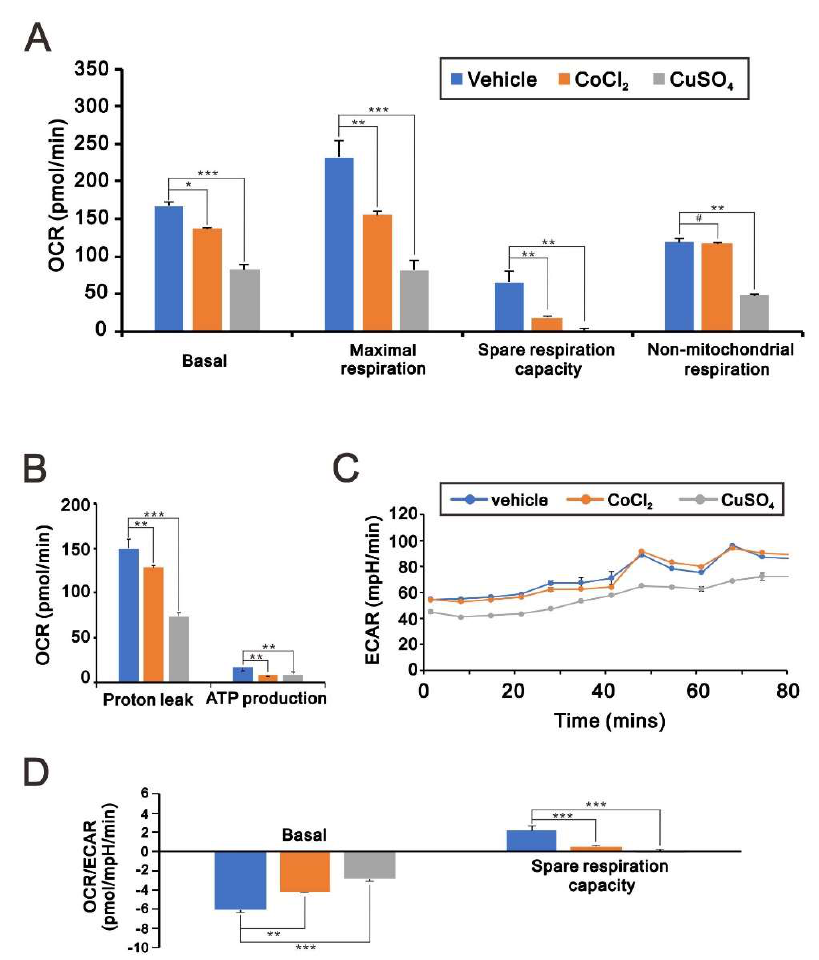
Figure 4. Effects of copper sulfate on oxygen consumption rate (OCR) and extracellular acidification rate (ECAR). ( A – D ) HeLa cells were incubated for 16 h with 200 μM CoCl 2 or 100 μM CuSO 4 , after which the cellular OCR ( A and B ) and ECAR ( C and D ) were measured in Seahorse XF24 bioenergetic assays. # p > 0.05, * p < 0.05, ** p < 0.01, and *** p < 0.001.